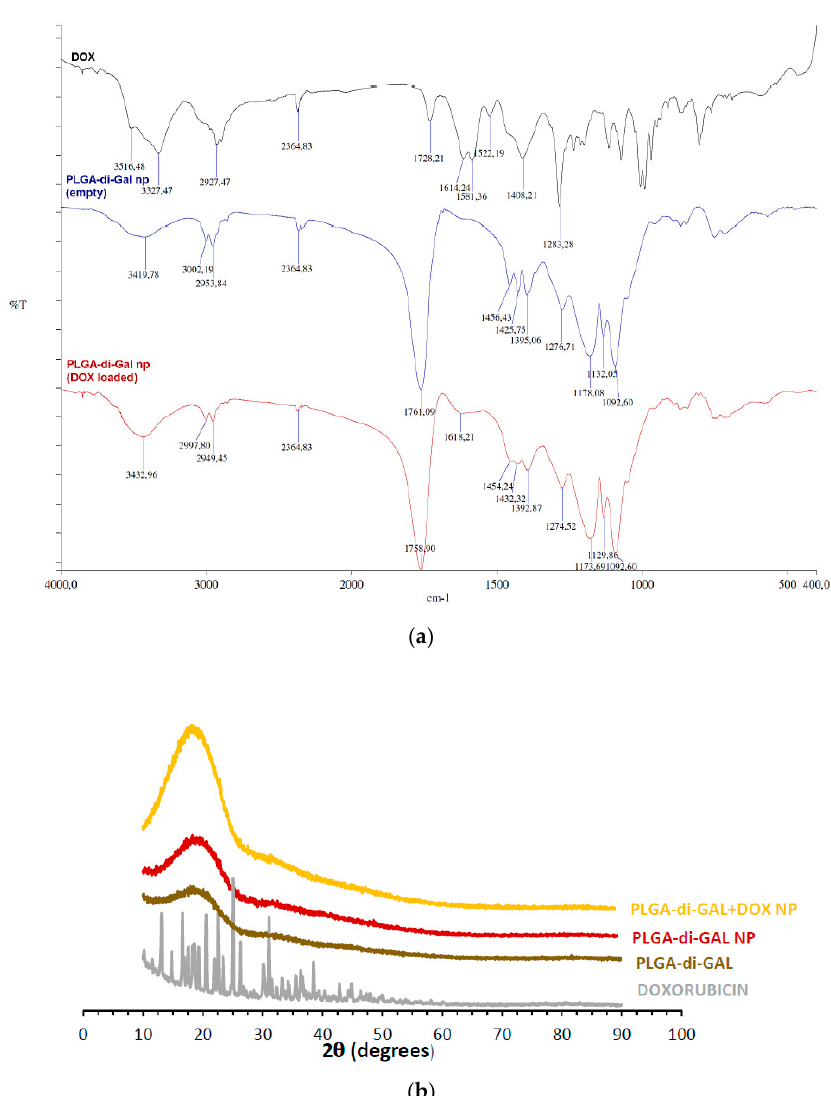
Figure 5. ( a ) FTIR spectra of DOX, empty PLGA-di-GAL NP and DOX loaded PLGA-di-GAL NP; ( b ) X-ray diffraction diagrams of DOX, PLGA-di-GAL polymer, unloaded PLGA-di-GAL NP and DOX loaded PLGA-di-GAL.